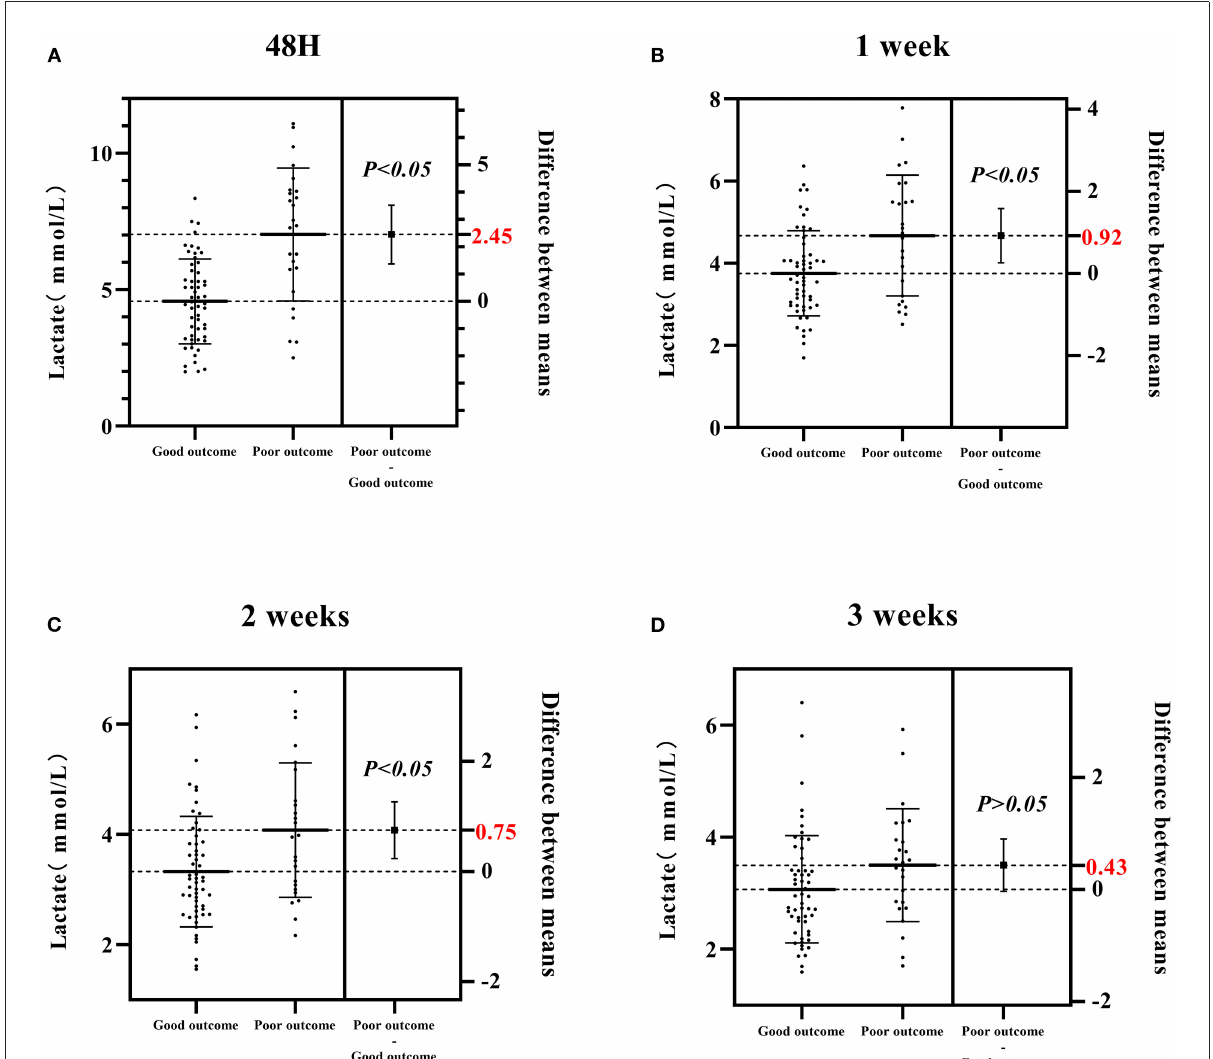
FIGURE2 Differences in the CSF lactate level between poor and good outcome groups at four different time points (48h, 1, 2, 3 weeks) after admission. (A) The CSF lactate level in poor and good outcome groups at 48h after admission. (B) The CSF lactate level in poor and good outcome groups at 1 week after admission. (C) The CSF lactate level in poor and good outcome groups at 2 weeks after admission. (D) The CSF lactate level in poor and good outcome groups at 3 weeks after admission. Good outcome was defined as a modified Rankin scale (mRs) score of 0–2; poor outcome was defined as a mRS score of